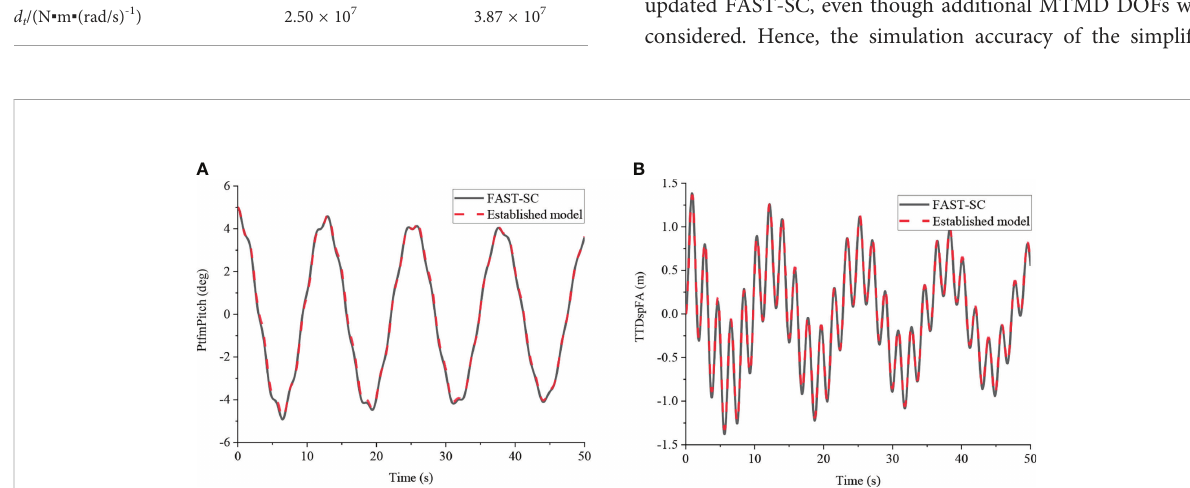
FIGURE 4 Time domain and frequency domain free decay responses of 5° initial platform pitch angle without TMD obtained using the parameter estimation model and updated FAST-SC model. (A) Platform pitch angle; (B) Tower-top